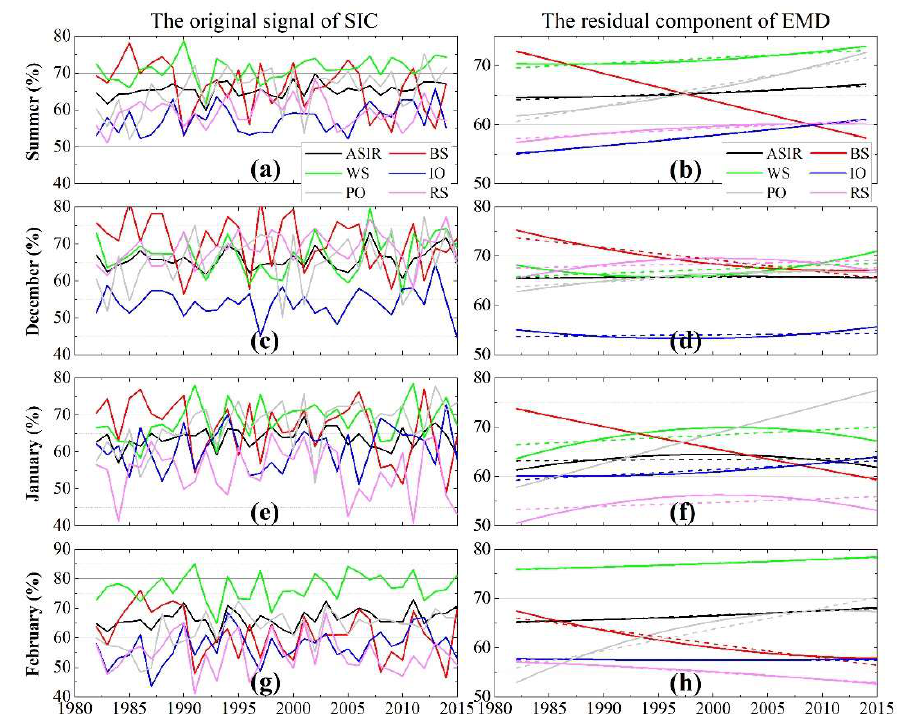
Figure 4. The same as Figure 3 but for SIC (%).